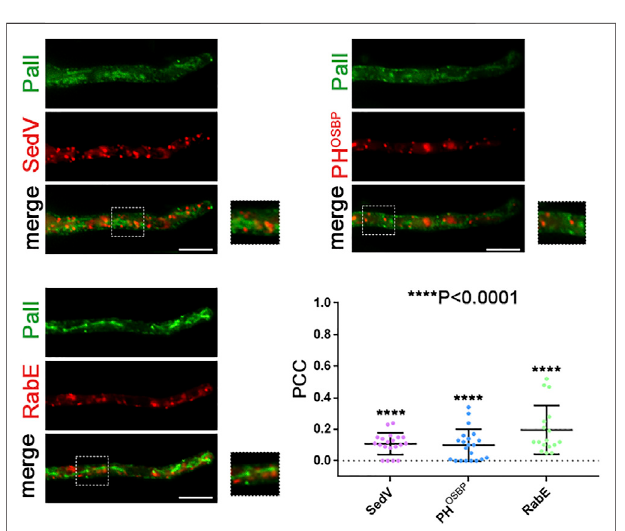
FIGURE 9 | Co-localization study of PalI with early and late Golgi markers. Localization of de novo -made PalI-GFP in three different strains co- expressing mCherry-SedV, mRFP-PH OSBP , or mRFP-RabE in single hyphae. Quanti fi cation (lower right panel) by calculating Pearson ’ s correlation coef fi cient shows no signi fi cant co-localization of PalI with the Golgi markers tested,ascon fi rmedbytheone-sample t -test(PCC=0.11±0.07,0.1±0.10, or 0.2 ± 0,15, with ****p < 0.0001 for mCherry-sedV, PH OSBP , or RabE respectively). Biological/technical replicates: 2/20, 2/21, and 2/17 for each strain respectively.